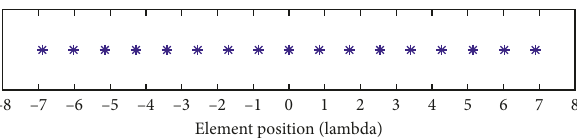
Figure 7: Diagram of optimized array layout of PSO-CVX.